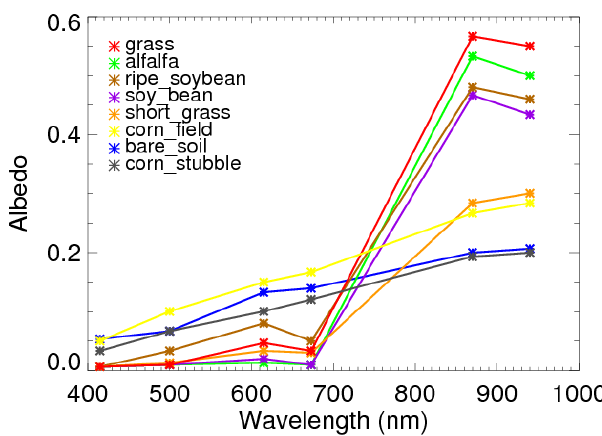
Fig. 2. Spectral albedo values at the MFR wavelengths for different surface types, adapted from figures in Liang et al. (2002).